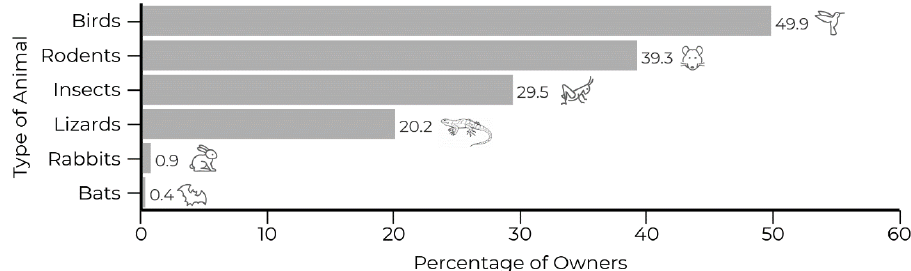
Figure 2. Percentage of owners that declare that their cats have brought back home a prey according to the type of animal. Table 1. Description of responses provided by cat owners (n = 2460) according to household and responsible ownership characteristics (number and percentage), and their association with cats bringing home any type of prey established through univariate logistic regression analysis. The p -value is